Question: What kind of plot is shown here?
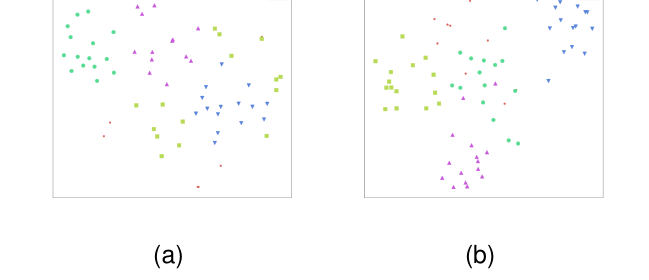
Answer: scatter